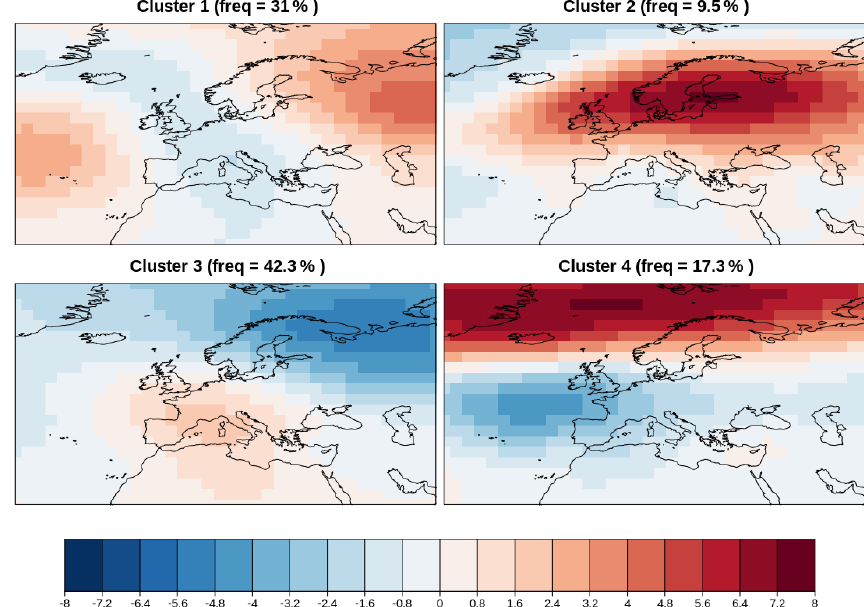
Figure 16. Four modes of variability for autumn (September–October–November) in the North Atlantic European sector for the RCP 8.5 scenario using BCC-CSM1-1 future projection during the period 2020–2075. The frequency of occurrence of each variability mode is indicated in the title of each map. The four clusters are reminiscent of the Atlantic Ridge, the Scandinavian Blocking, the NAO + , and the NAO- pattern. Result for recipe_modes_of_variability.yml ; see details in Sect.